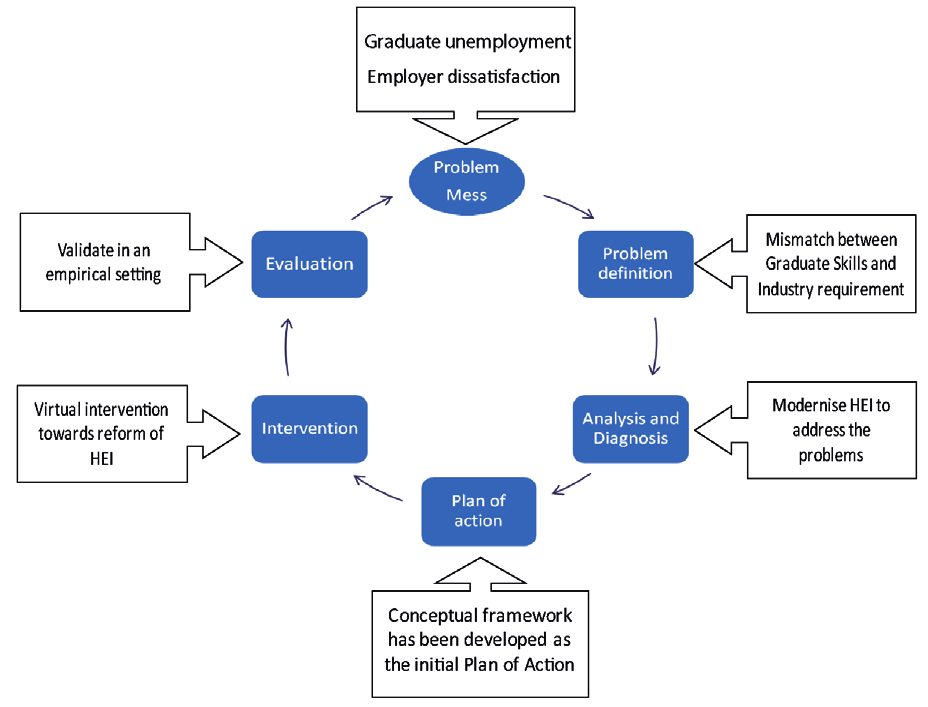
Figure 2. Basic process of the regulative cycle (adopted from Van Strien,